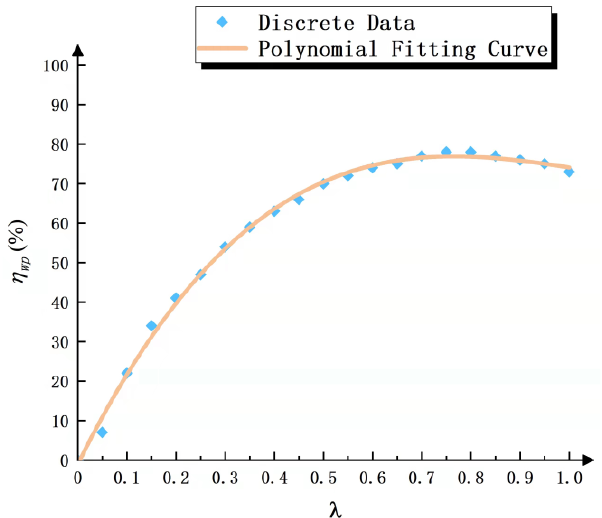
Figure A1. The relationship between water pump efficiency and the ratio of mass flow